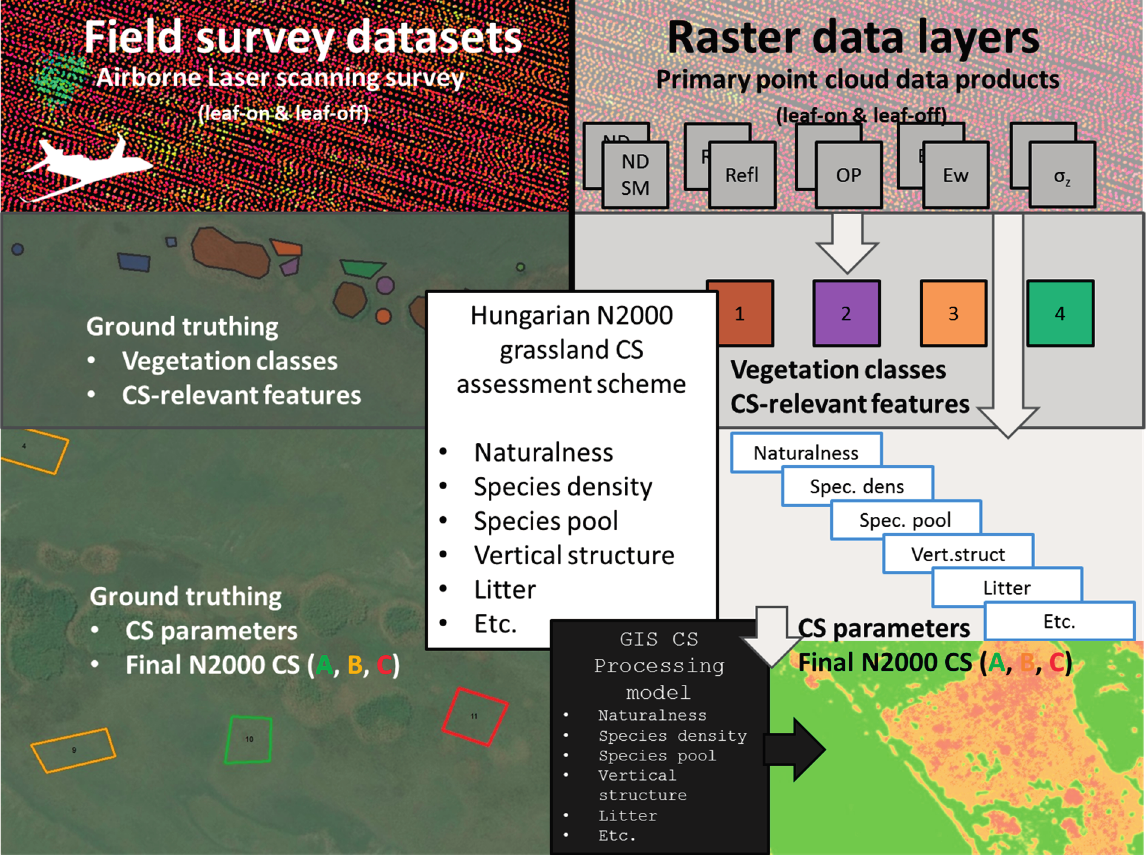
Figure 2. Simplified workflow scheme of ALS data processing, vegetation and feature classification, calculation of CS parameter layers and final CS map. Calibration and validation was carried out individually for each processing